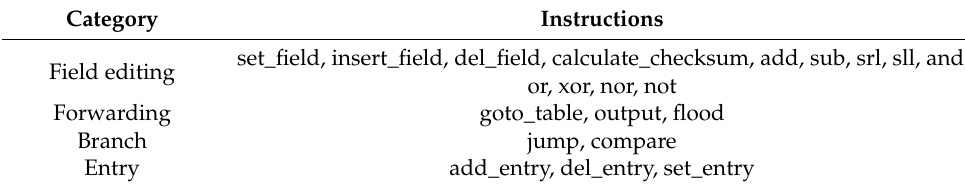
Table 3. Instruction set in the pipeline.